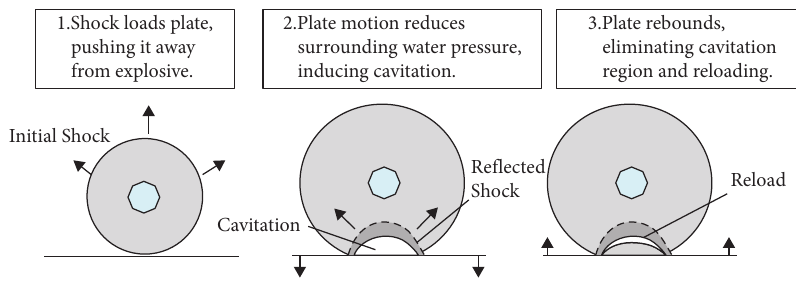
Figure 21: Wall cavitation mechanism [46].